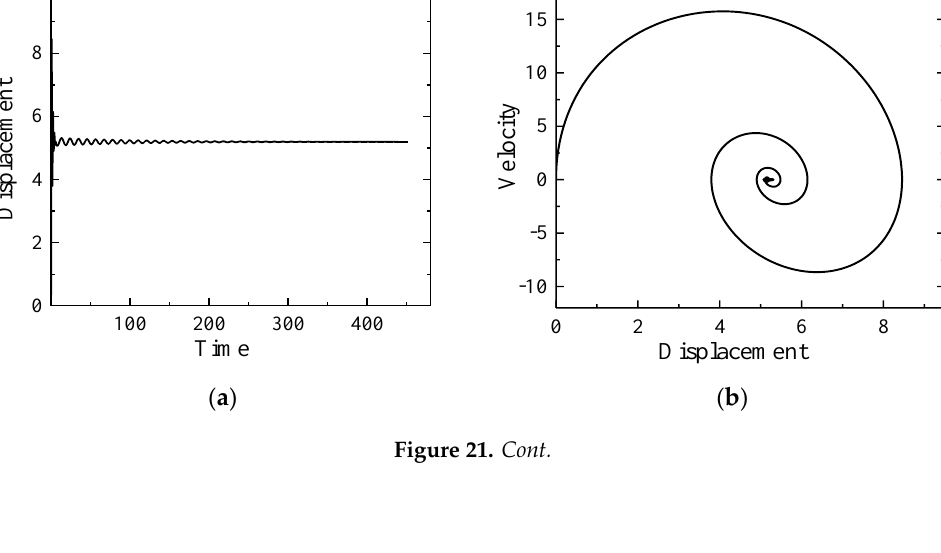
( d ) Figure 21. Evolutions of the displacement and speed-displacement diagram of brake disc and brake shoe at the stiffness of k 1 = 0.5 N/m and k 2 = 1 N/m. ( a ) Evolution of the displacement of the brake shoe. ( b ) Evolution of the speed-displacement diagram of the brake shoe. ( c ) Evolution of the displacement of the brake disc. ( d ) Evolution of the speed-displacement diagram of the brake disc. 100